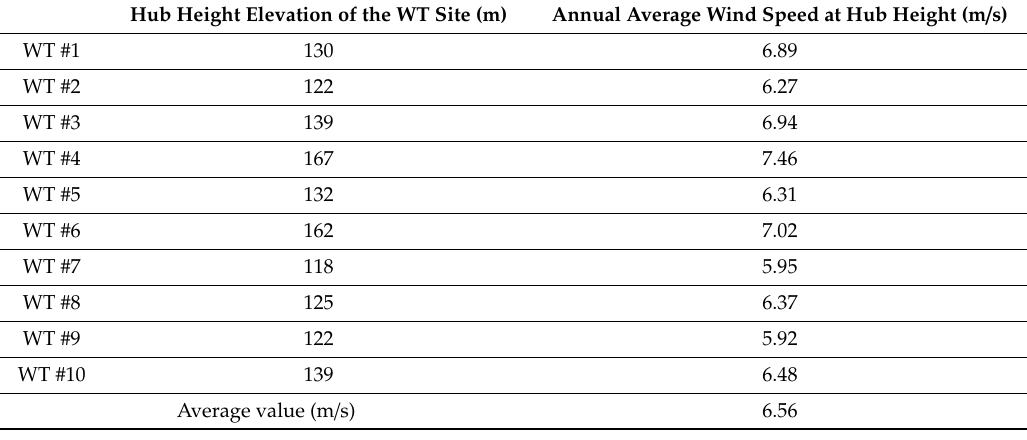
Table 3. Characteristics of the wind at Noma Wind Park for the year from April 2004 to March 2005. Hub Height Elevation of the WT Site (m)